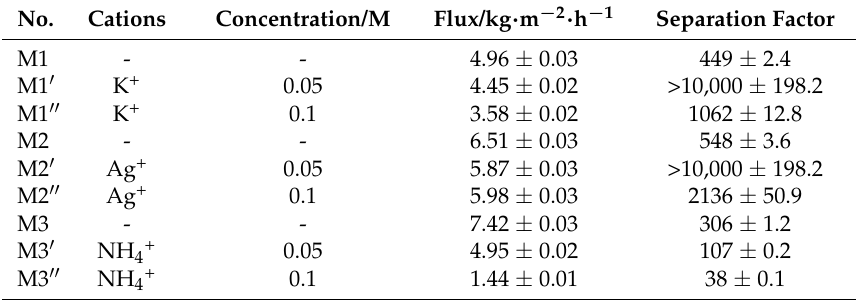
Table 4. Pervaporation (PV) performances of the NaA zeolite membranes treated by various concentrations of monovalent cation solutions, by dehydrating 90 wt % ethanol/water mixture.